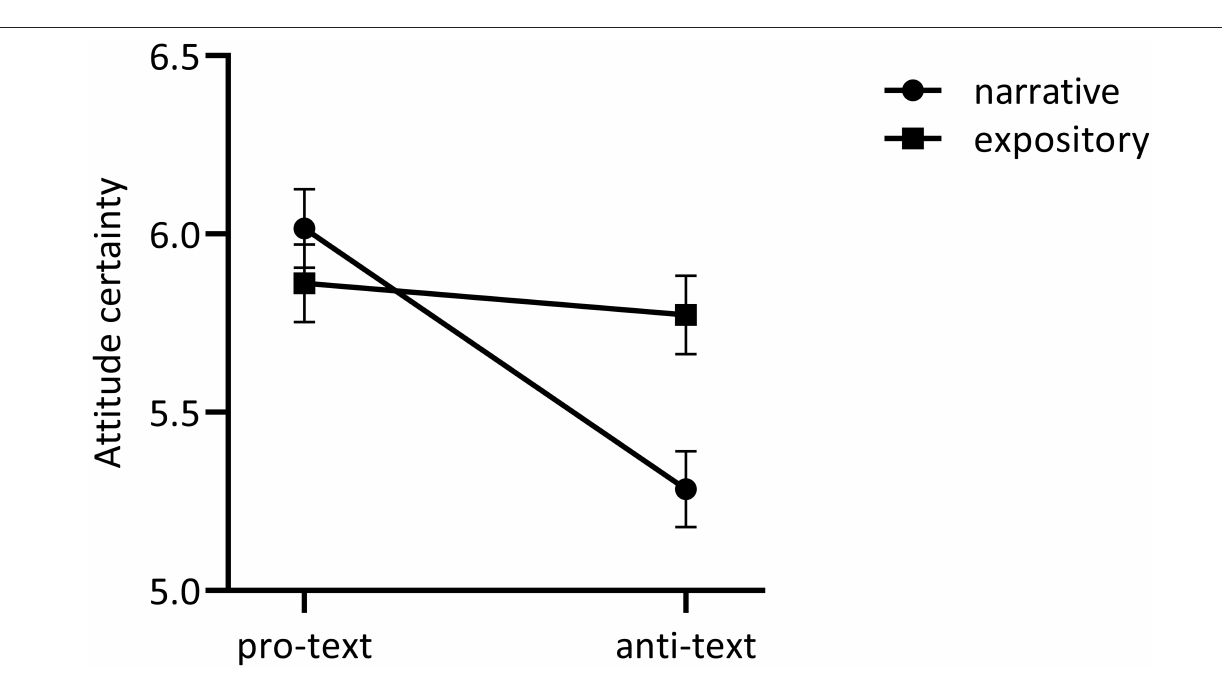
attitude showed no significant format ∗ content interaction for participants with extremely positive vaccination attitudes ( + 1 SD above the mean, M = 7.00, t = 0.69, p = 0.49) but did